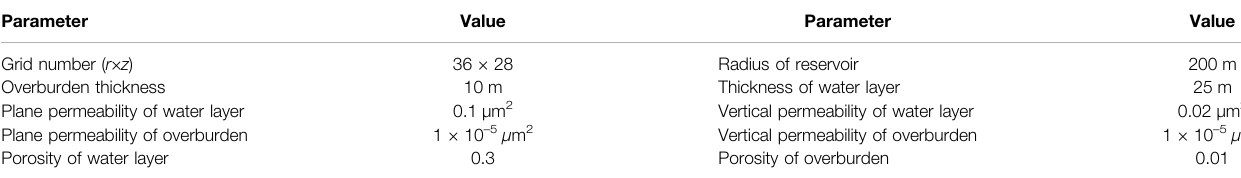
TABLE 1 | Basic parameters of the coupled model.